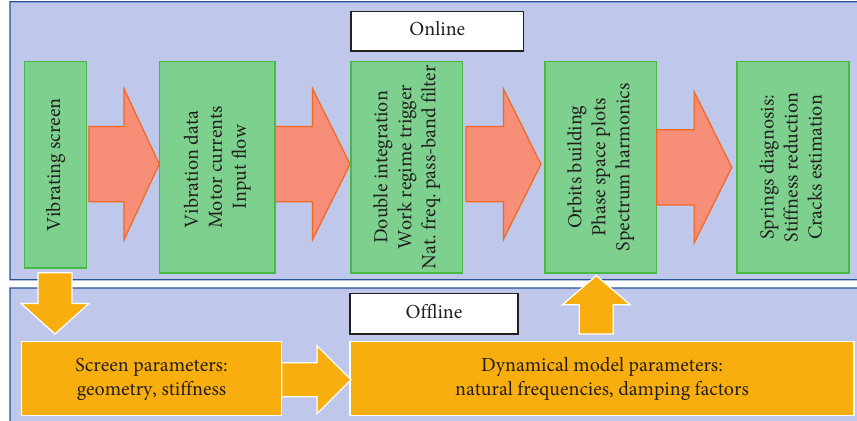
Figure 16: The block diagram of diagnostics procedure